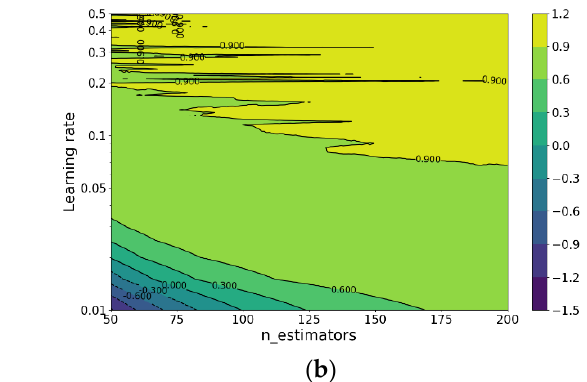
From the obtained result, when n_estimators and learning_rate are 64 and 0.365, re-